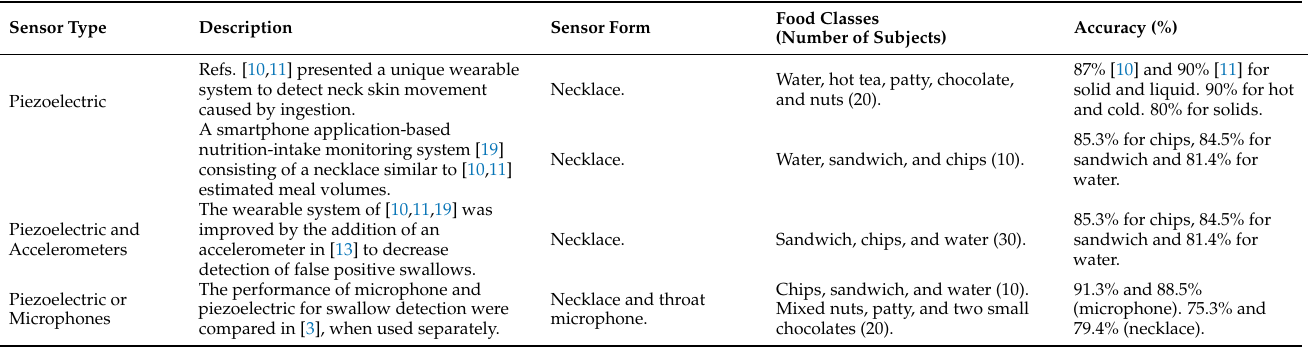
Table 1. A summary of necklace-based intake monitoring